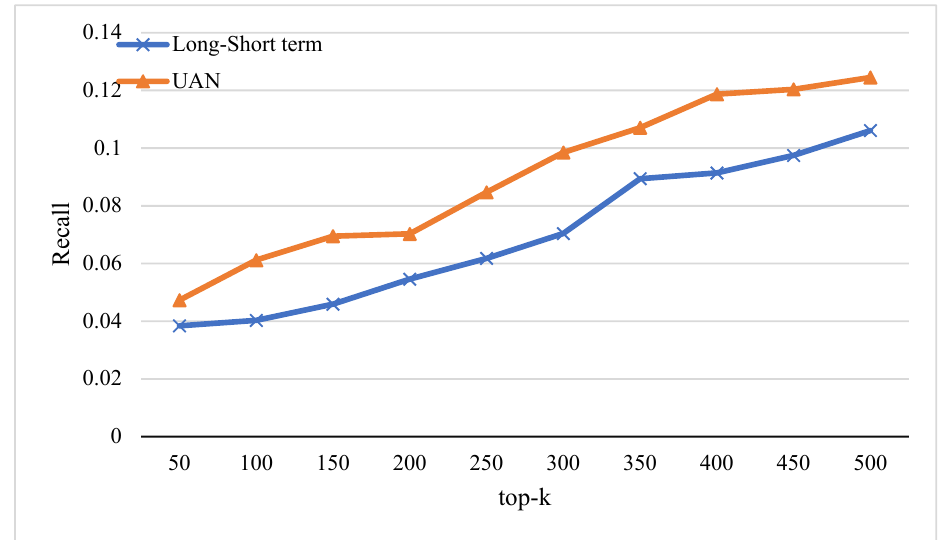
Figure 10. Comparison of top-k recommendation recall rate between image recommendation algorithm based on UAN and image recommendation algorithm based on users’ long-term and short-term preferences.